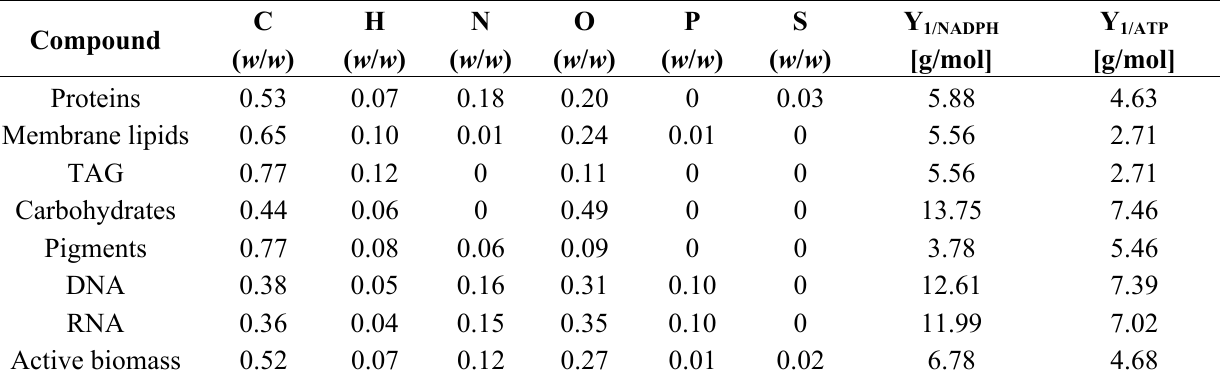
Table 1. Elemental composition of molecular components of biomass and yield coefficients for their synthesis based on ATP and NADPH requirements